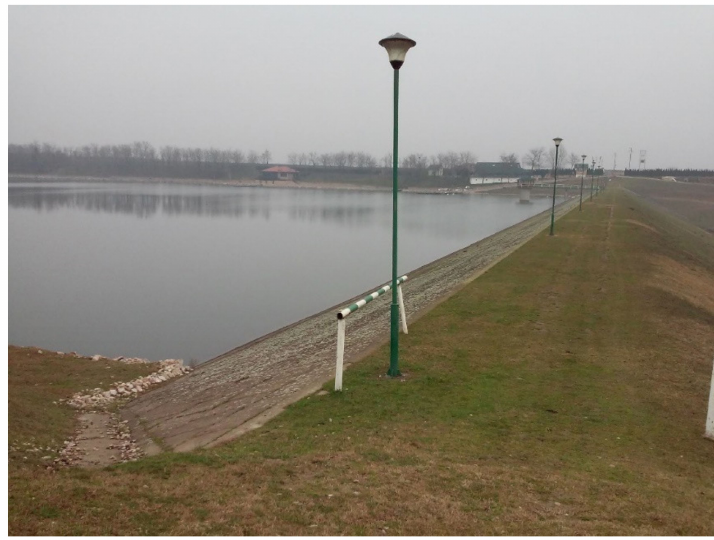
Figure 1. Šelevrenac embankment